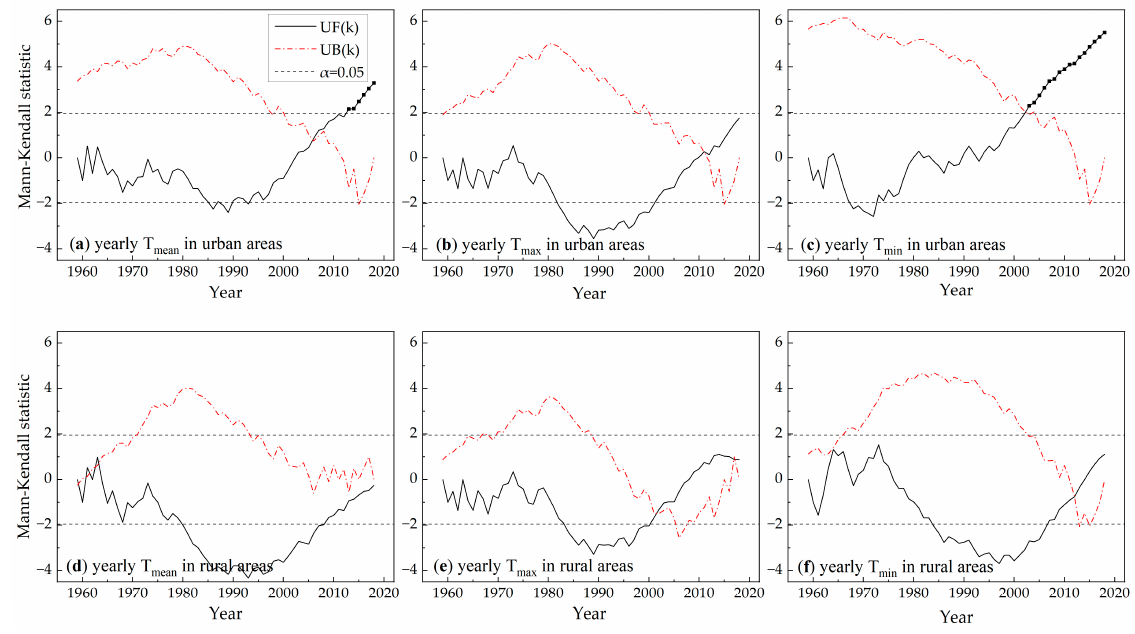
Figure 5. The Mann–Kendall statistic curves during the period of 1959–2018: ( a ) mean yearly temperature in urban areas; ( b ) mean yearly temperature in rural areas; ( c ) mean annual daily maximum temperature in urban areas; ( d ) mean annual daily maximum temperature in rural areas; ( e ) mean annual daily minimum temperature in urban areas; ( f ) mean annual daily minimum temperature in rural areas, and the period where the tendency is statistically significant UF(k) values higher than the limit of 1.96 at the significance level α = 0.05 indicated with black dots.